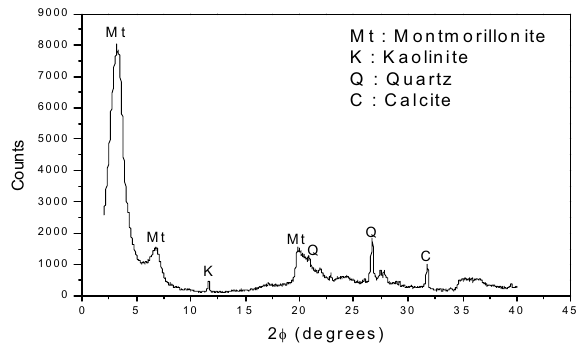
Fig. 2 X-ray diffraction of VG69 organophilic clay